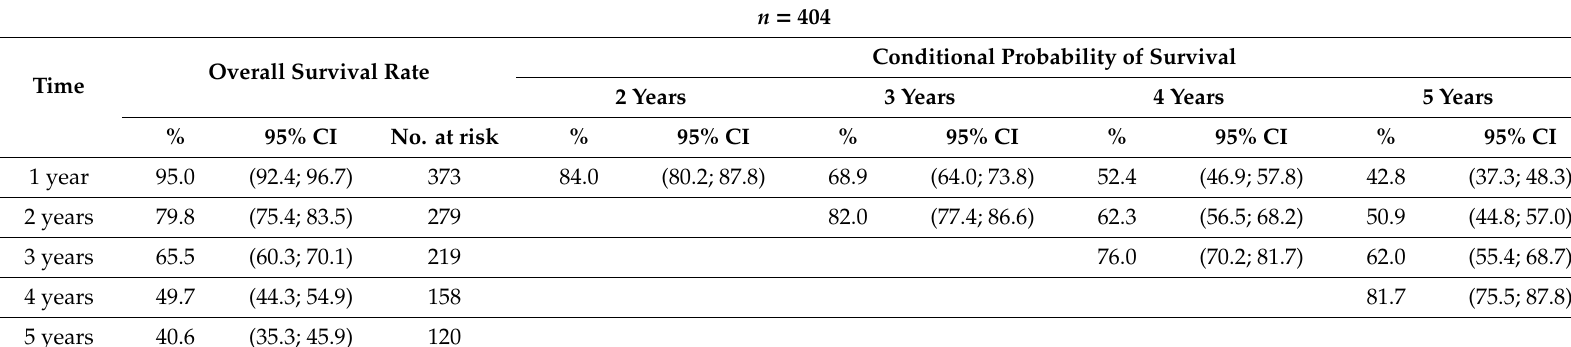
Table 3. Overall survival rates (left) and conditional probabilities of survival (right) depending on the survived time interval. n =